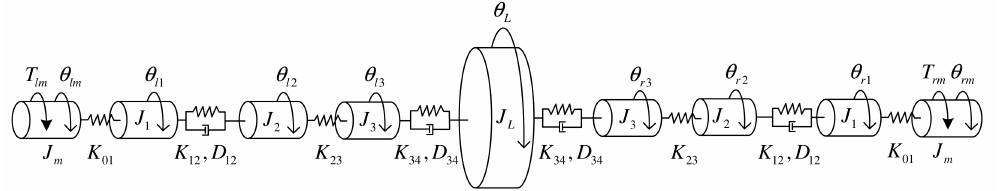
Figure 9. The overall linear model of the